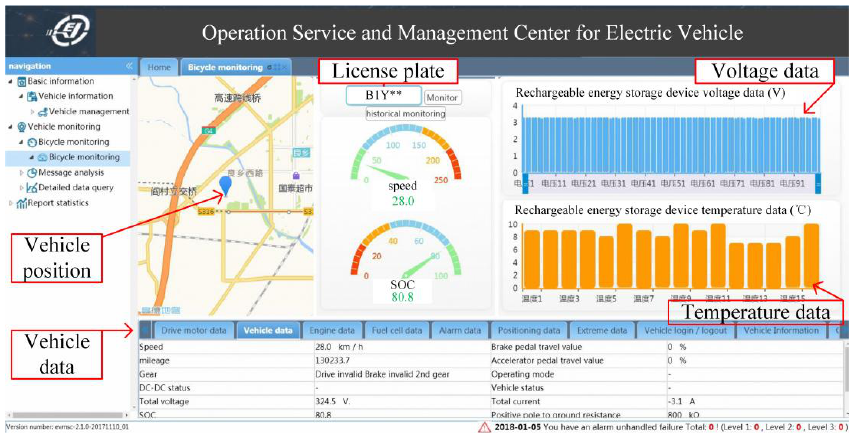
Figure 3. Operation interface in Operation Service and Management Center for Electric Vehicle